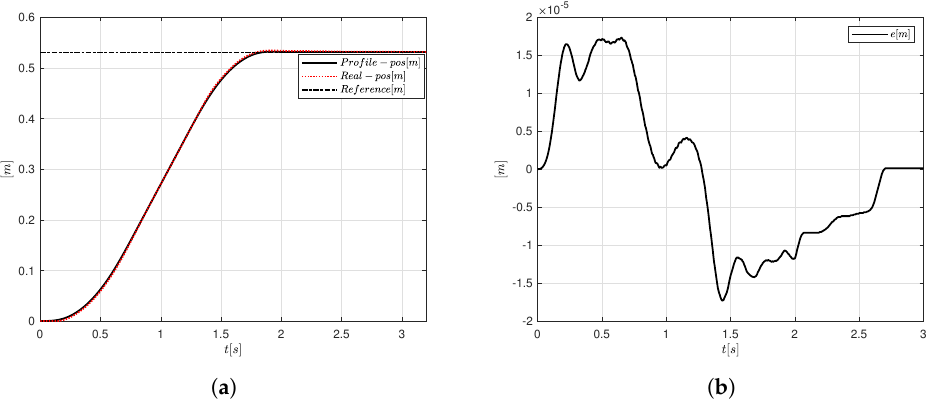
Figure 12. Motion controller based on PID-like FLC, and S-curve velocity profile implementation, ( a ) position and ( b )